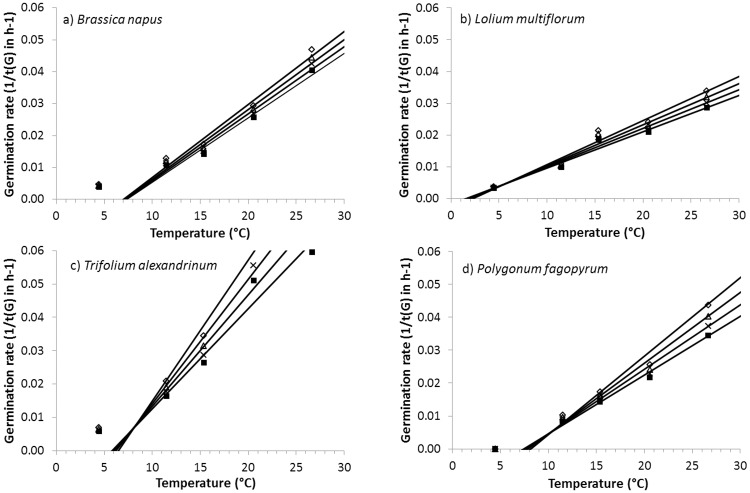
Linear relationships fit between observed germination rate and temperature for four fractions percentages of the seed population, 20% (◊), 30% (Δ), 40% (x) and 50% (■), for Brassica napus (Brassicaceae), Lolium multiflorum (Poaceae), Vicia sativa (Fabaceae) and Polygonum fagopyrum (Polygonaceae).